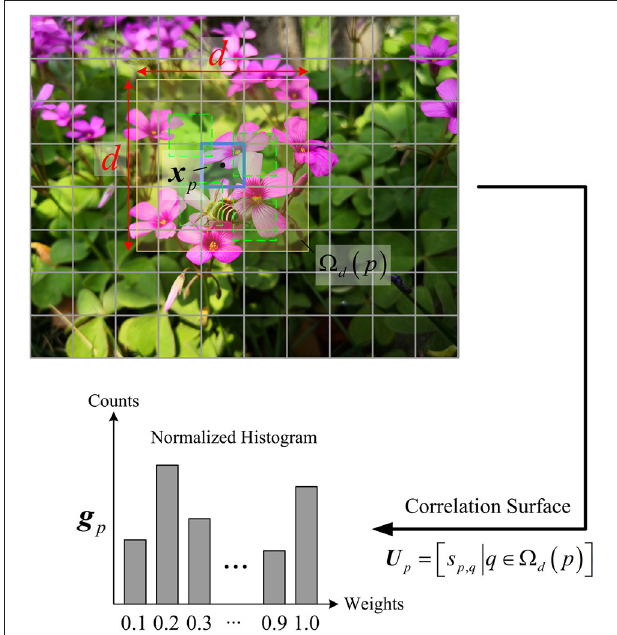
FIGURE 2 | Illustration on the traditional extraction of contexts.